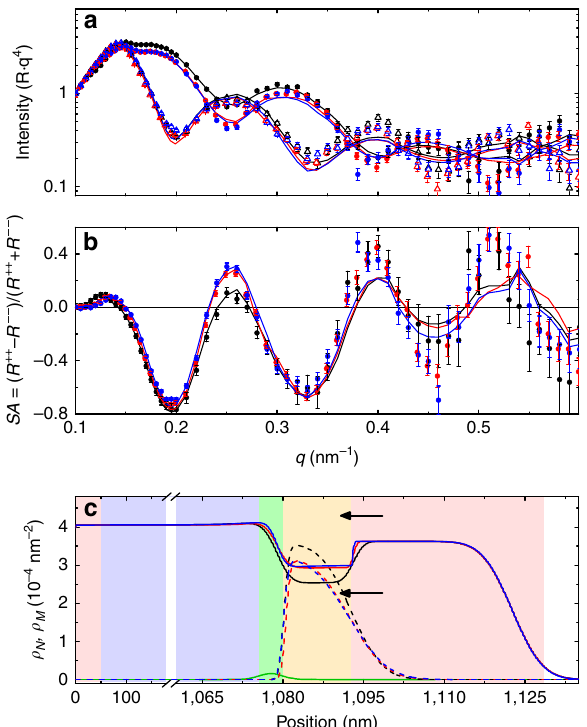
Figure 2 | PNR results of thermally conditioned control sample. ( a ) Fitted PNR data, with R þ þ (R (cid:2) (cid:2) ) identified by solid circles (open triangles), scaled by q 4 and ( b ) spin asymmetry for the sample as-grown and after thermal-only conditioning. ( c ) Depth-dependent nuclear and magnetic SLD, r N and r M , extracted from the PNR. In all panels black, red and blue lines identify the as-grown, once-treated (15min) and twice-treated (2 (cid:3) 15min) samples, respectively. In c the solid and dashed lines identify r N and r M , respectively, and the green line identifies r imag . Background colours in c represent (red) Pd, (purple) AlO x , (green) GdO x and (yellow) Co. In a and b the experimental data are shown as symbols, and the lines are fits corresponding to the depth profile shown in c . Error bars in a and b correspond to ± 1 s.d. Arrows in a and b identify the bulk r N for Co (2.25 (cid:3) 10 (cid:2) 4 nm (cid:2) 2 ) and CoO (4.29 (cid:3) 10 (cid:2) 4 nm (cid:2) 2